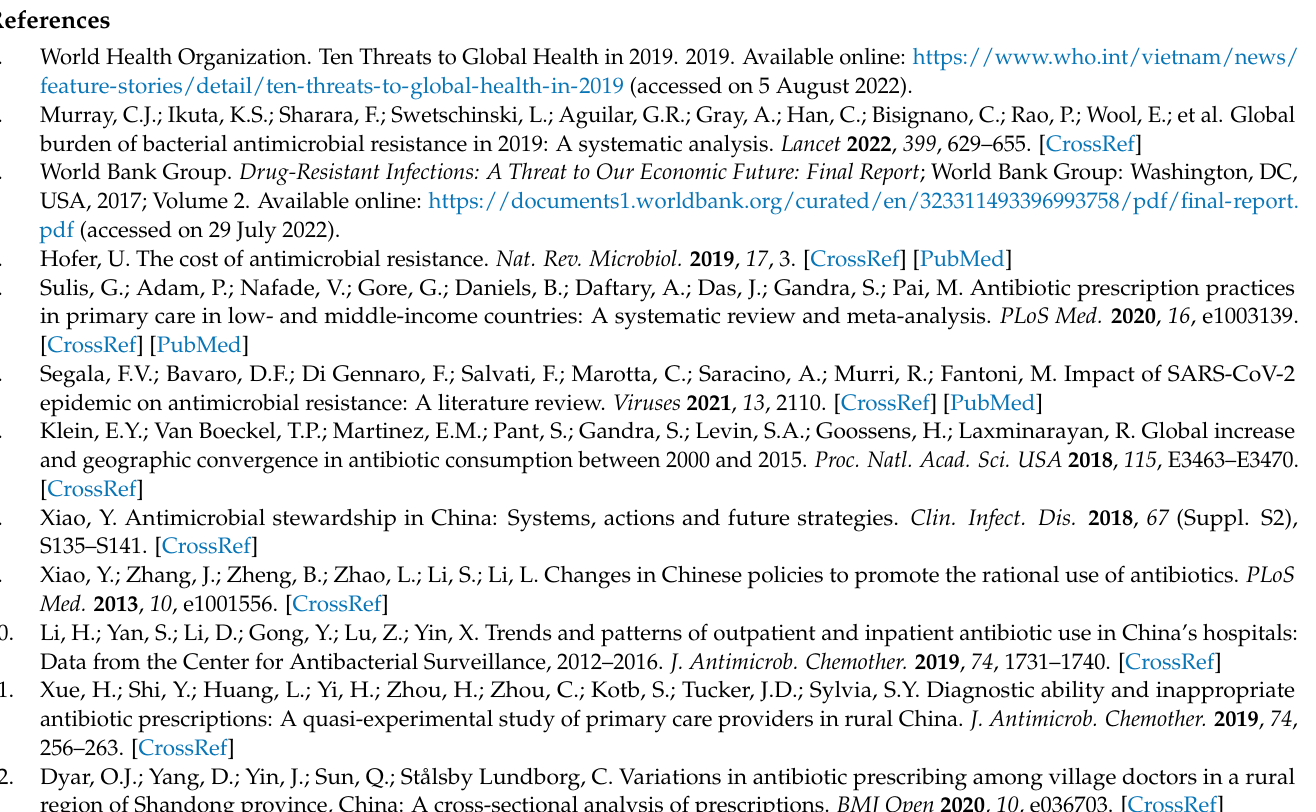
Table S4. Antibiotic ATC group patterns stratified by age (in years). Table S5. Antibiotic ATC group patterns stratified by chronic